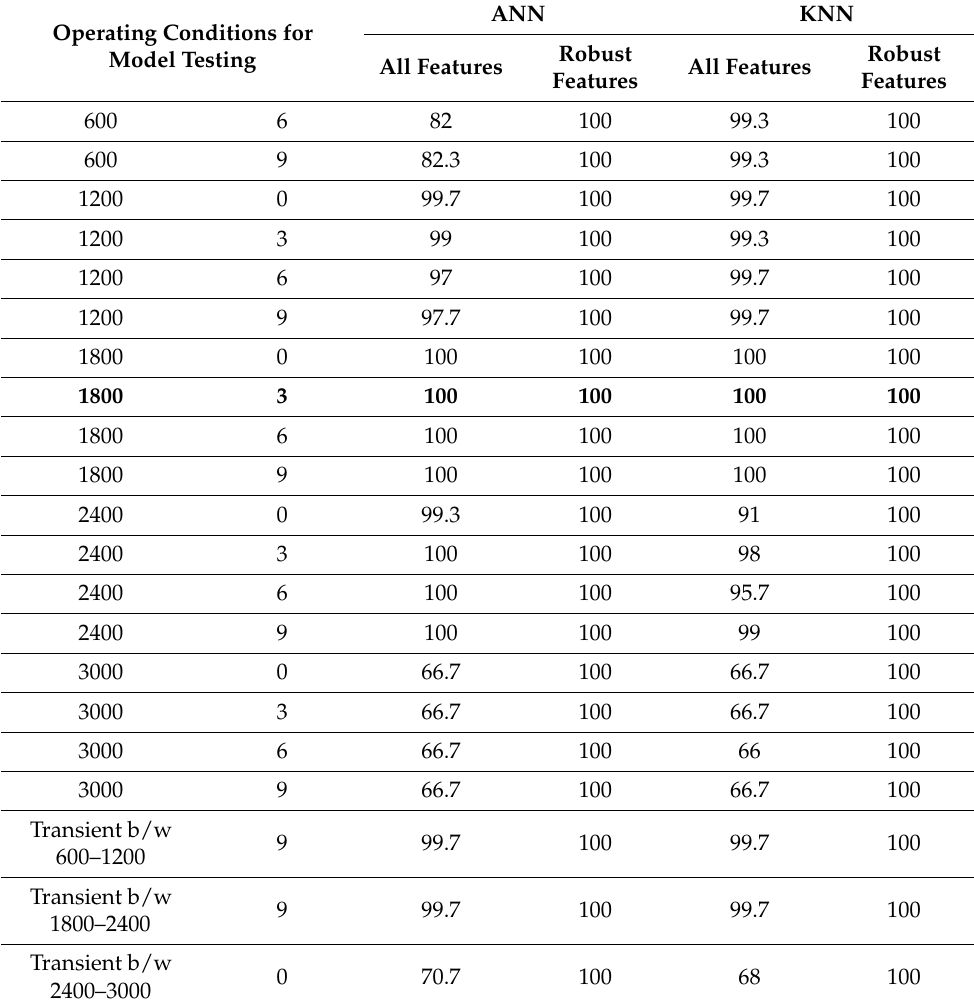
( b ) Figure 15. KNN confusion chart (trained at 1800 rpm, 3 Nm load; tested at 2400–3000 rpm, 0 Nm load): ( a ) all features; ( b ) robust features.